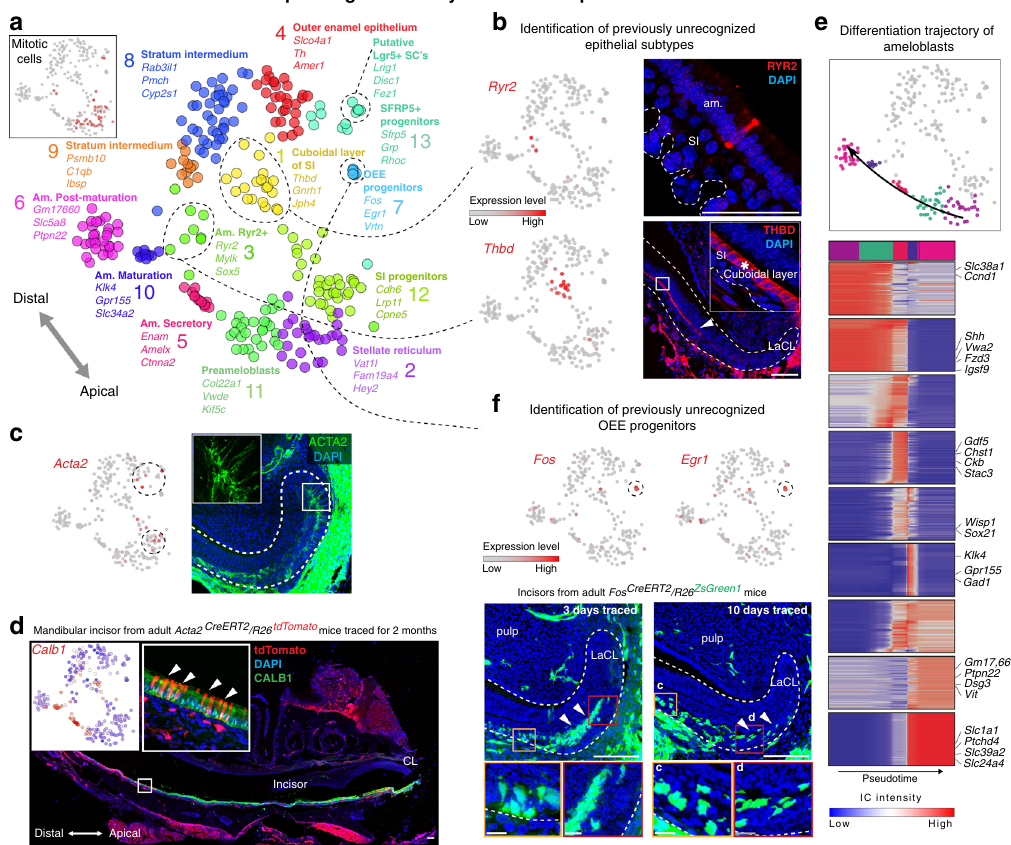
Fig. 2 In-depth single-cell analysis of dental epithelium. a t-SNE dimensional reduction shows subpopulations of 268 single epithelial cells. 13 unbiased clusters (colors) reveal previously unrecognized stem, progenitor and mature epithelial subtypes. Inset: mitotic signature as de fi ned by average expression of cell-cycle-related genes. b Identi fi cation of a previously unrecognized cellular subtypes of epithelial layer. RYR2 + cells in ameloblasts ’ layer and THBD + subpopulation of stratum intermedium organized into cuboidal layer found by immunohistochemistry. c Panel on the right shows localization of ACTA2- expressing cells inside the labial cervical loop (immunohistochemistry) and corresponding expression of Acta2 predicted from RNA-seq analysis (left panel). d Long-term (2 months) lineage tracing of a Acta2 CreERT2 /R26 tdTomato dental epithelial stem cells shows the traced cells in both apical (near the cervical loop) and distal ameloblasts. Ameloblast character was proved both morphologically and by expression of CALB1 (immunohistochemistry). e Transcriptional program of ameloblasts differentiation. Four clusters corresponding to different stages of ameloblasts maturation (upper). Transcriptional states of ameloblasts progenitors were modeled as a single trajectory, which reveals sequence of cell state transitions and linked activity developmental gene modules (bottom). Heatmap: the cells (columns) are arranged according to estimated pseudotime, genes (rows) were clustered in nine modules. Smoothed gene expression pro fi les are shown. f Transient progenitor population found in labial cervical loop is demarcated by the expression of Egr1 and Fos . Panels in the bottom part shows the lineage tracing of Fos CreERT2 /R26 ZsGreen1 . Insets show the lineage traced cells in outer enamel epithelium. Of note, Fos CreERT2 /R26 ZsGreen1 traced cells in epithelial and mesenchymal compartments are of distinct origins since compartments are spatially separated. (LaCL Labial Cervical Loop, SI Stratum Intermedium, Am. Ameloblasts). Scale bars: b , d , e : 50 µ m; c and insets of e : 10 µ